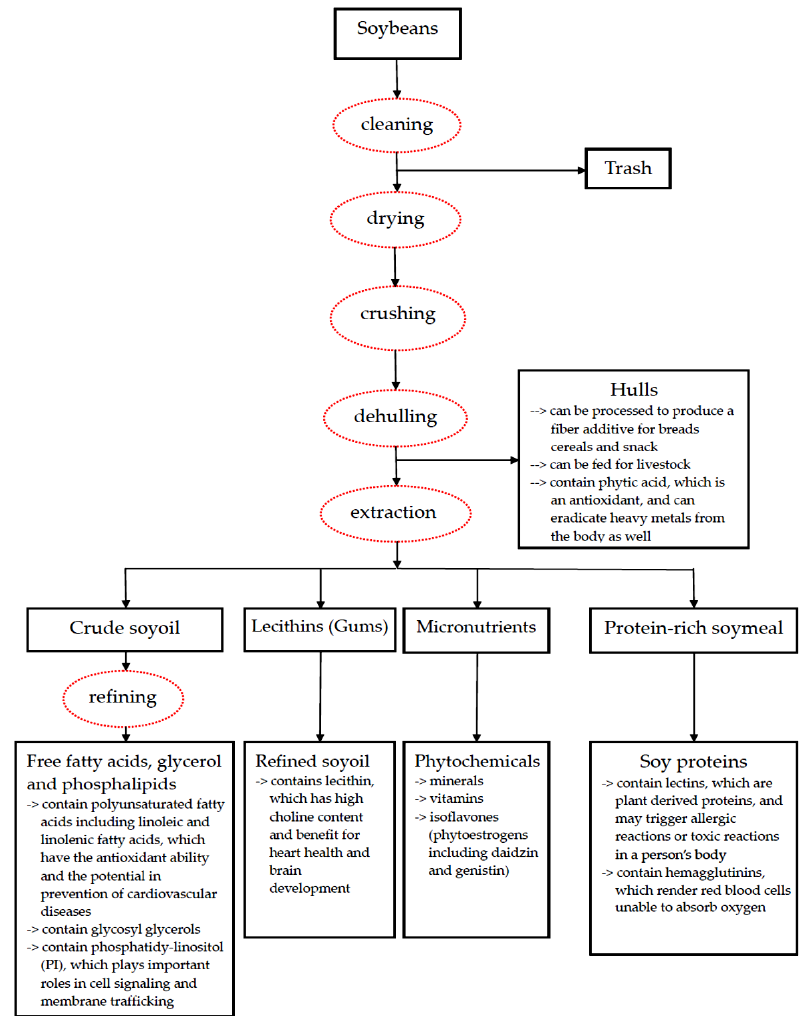
Figure 1. The processing, components and functions of soybeans